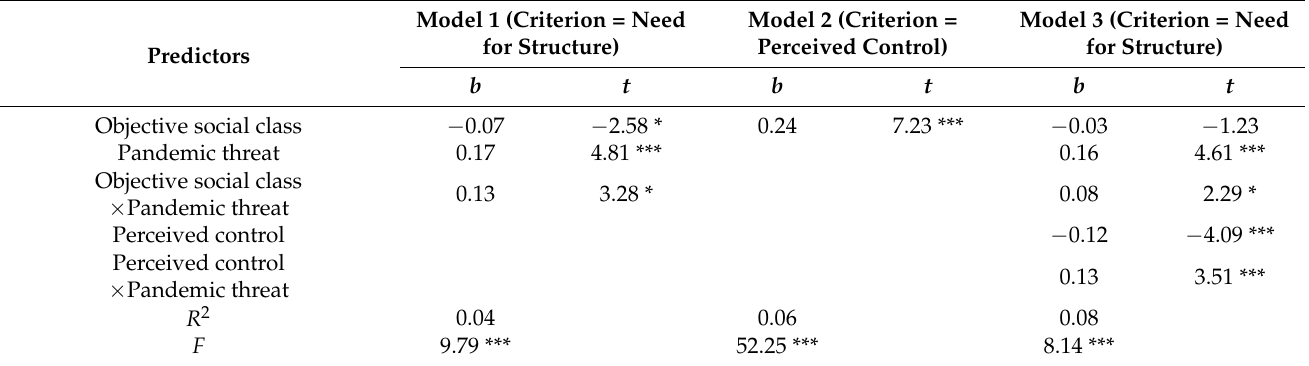
Table 2. Multiple regression analyses of moderated mediation